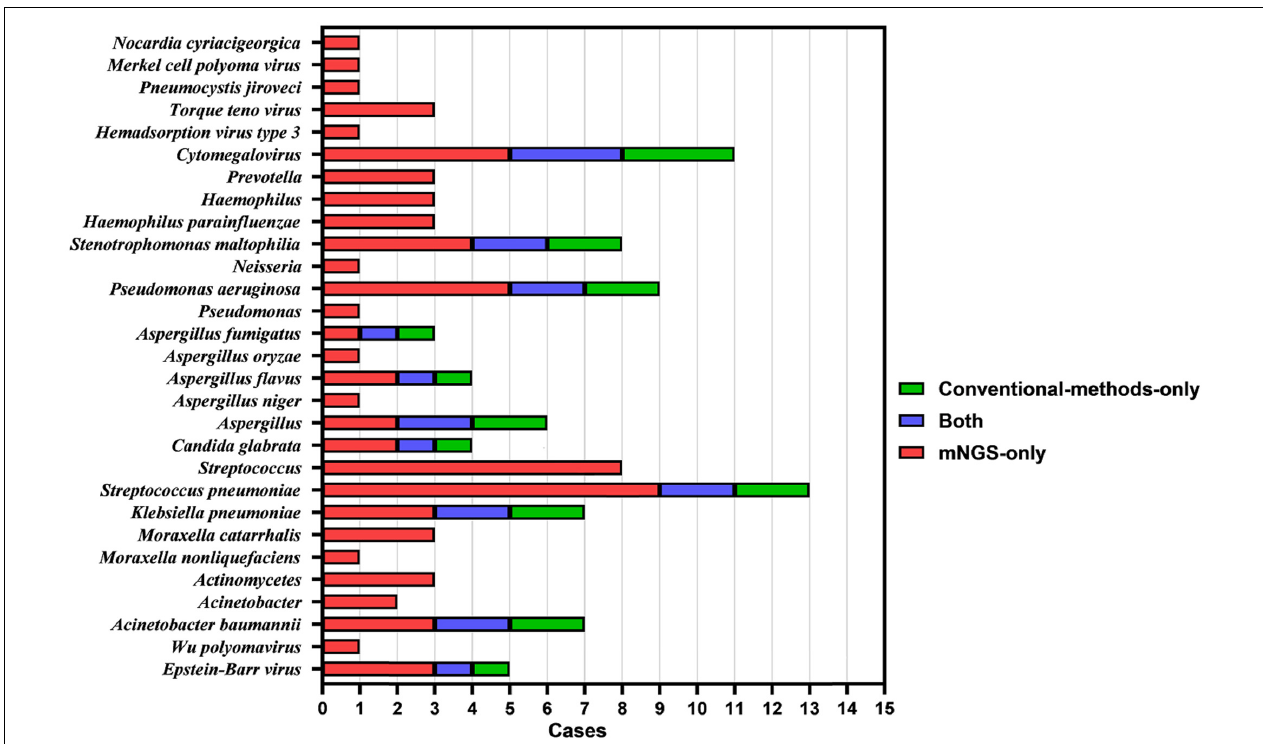
FIGURE 4 | Histogram showing the results of mNGS and conventional methods in identifying mixed infection in BALF specimens of patients with PTB and NTM-PD.